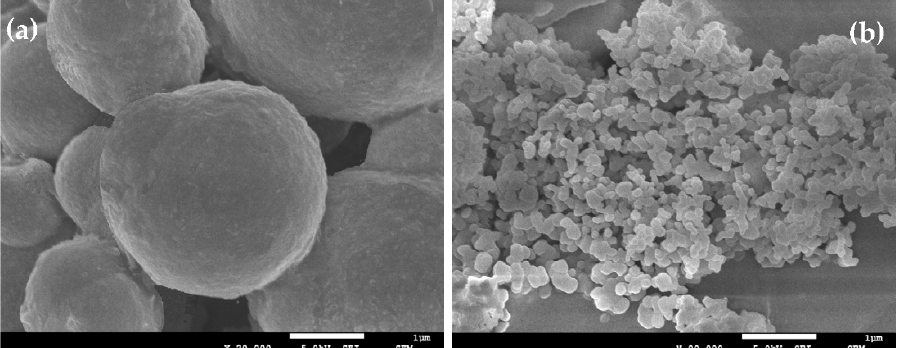
Figure 2. SEM images of microstructure morphology: ( a ) pure micron-sized CI particles; ( b ) pure nanoparticles Fe 3 O 4 .